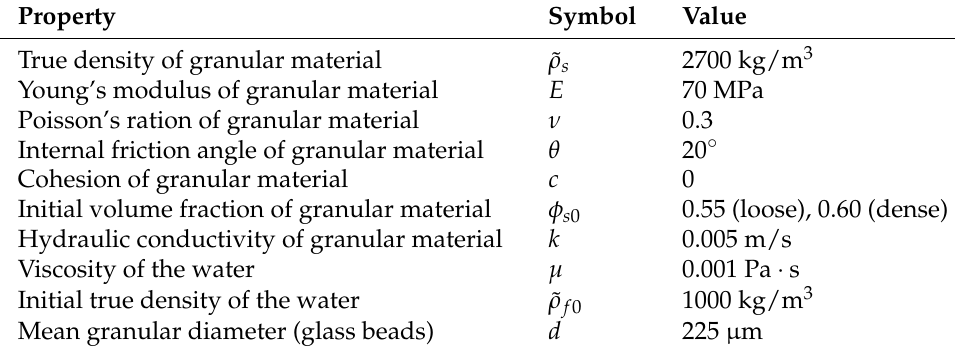
Figure 8. Submerged granular column collapse. D w is the water depth. L i and H i are the initial length and height of the granular column, respectively. Table 2. Material properties for the simulation of an initial 6 cm × 8 cm ( L i × H i ) granular column collapse in